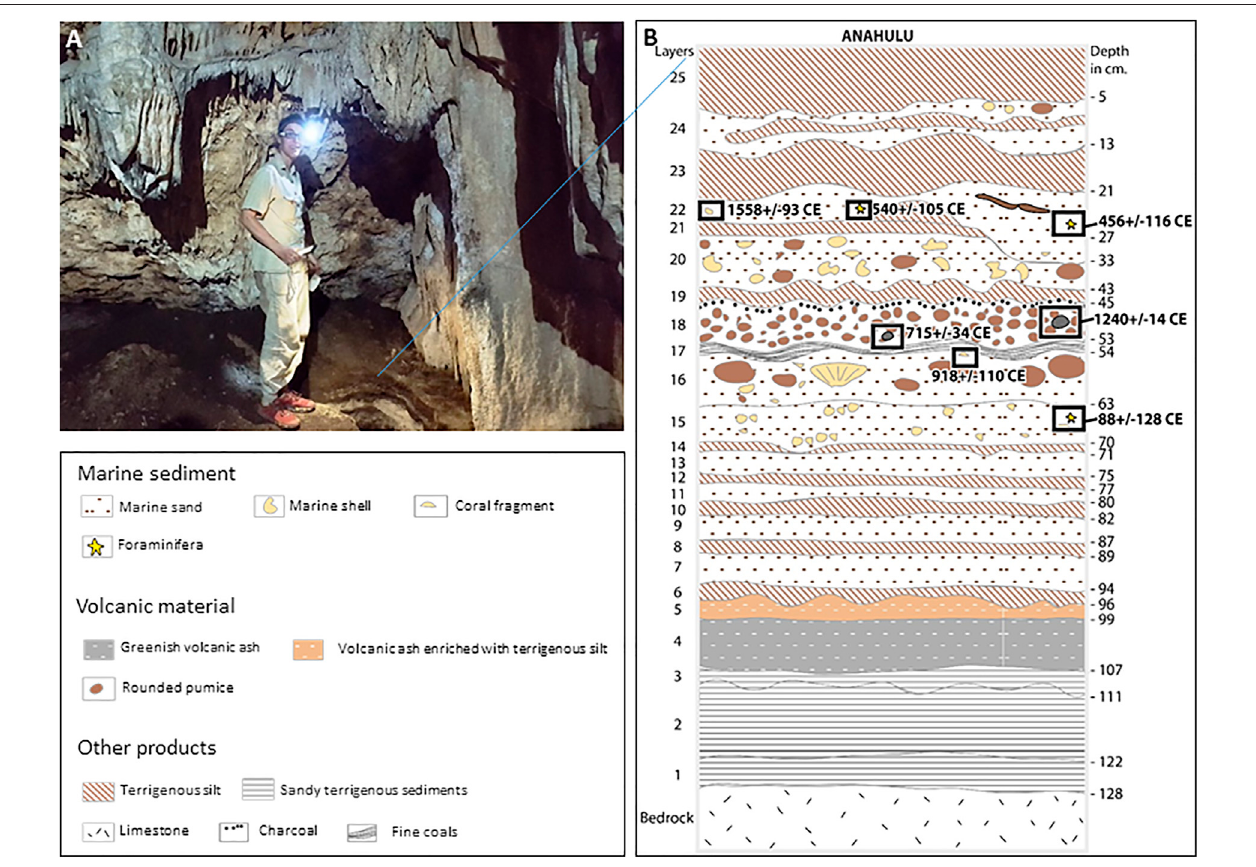
FIGURE 5 | Sedimentary sequence within the Anahulu cave, showing two sequences of tsunami deposits. 1 – 3: Predominantly sandy terrigenous sediments. 4: Greenish volcanic ash. 5: Volcanic ash enriched with terrigenoussilt. 6 – 14: silty layers alternatingwith layers ofslightlycoarser material, interpreted as periodic entries of eroded material from the slope upstream of the cave through fractures. 15: Coarse marine bioclastic sand, with numerous shell fragments and clasts of coral limestone. 16: Coarse marine sand withabundant large shells,rounded pumice upto9 cmindiameterand terrigenouscavebottom material. 17: 2-cm layer of fi ne coals. 18: 8-cm layer of small well rounded pumice. 19: Thin layer of brown compact silt. 20: White bioclastic sand mixed with terrigenous silty material, numerous coral debris, shells and pumice. 21: Brown silts. 22: Marine sand sometimes enriched with terrigenous silts. Presence of rip-up clasts. 23 – 24: alternating terrigenous elements and stretched marine sands. 25: Blackish silty layer containing recent anthropic